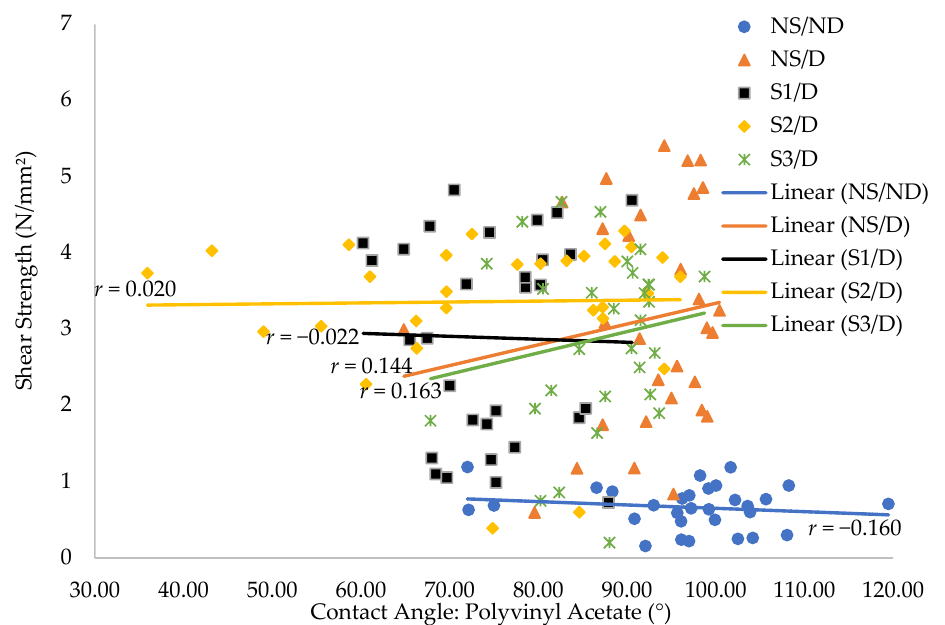
Contact Angle: Polyvinyl Acetate (°) Figure 10. Correlation between shearing strength of glue-laminated timbers and contact angles (pol- Figure 10. Correlation between shearing strength of glue-laminated timbers and contact angles (pol- Figure 10. Correlation between shearing strength of glue-laminated timbers and contact angles yvinyl acetate) for laminas. yvinyl acetate) for laminas. (polyvinyl acetate) for laminas.